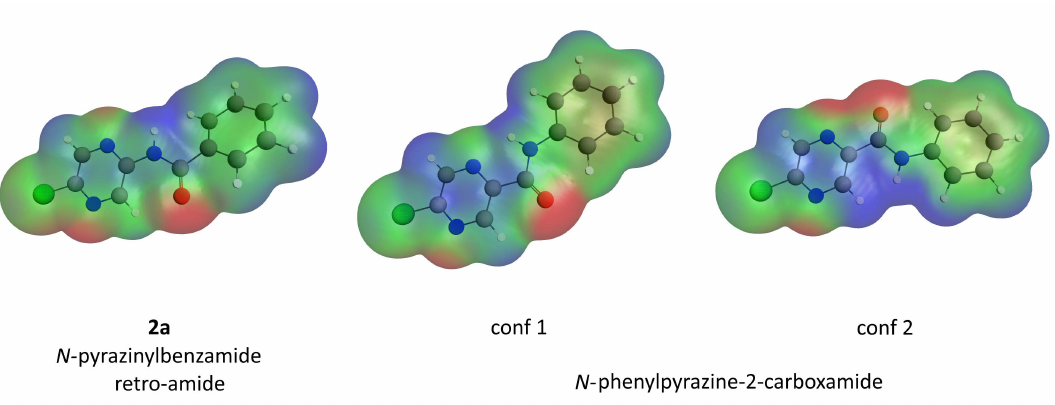
Figure 3. Analysis of selected pharmacophore features of the minimized conformations. Turquoise dot—HBA, violet dot—HBD. Spheres represent the respective projections.